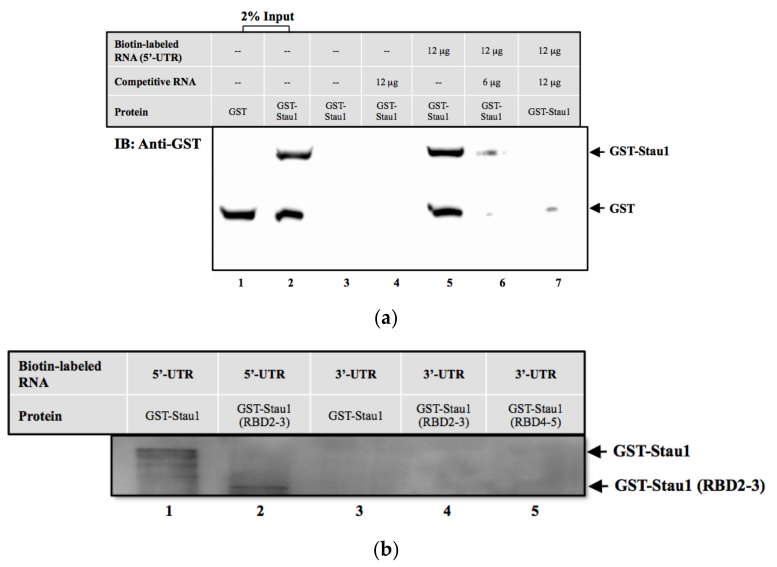
Figure 1. Stau1 binds to 5 (cid:48) untranslated region of EV-A71 RNA. ( A ) Stau1 binds to EV-A71 viral RNA in an in vitro RNA pulldown assay. The recombinant GST-tagged Stau1 protein was expressed and purified from Escherichia Coli . The biotin-labeled EV-A71 viral RNA was used for the RNA pulldown analysis. Lanes 1 and 2: Input of the recombinant GST or GST-Stau1 protein; Lane 3: GST-tagged Stau1 protein only; Lane 4: GST-tagged Stau1 protein interacted with non-biotin-labeled RNA (competitive RNA); Lane 5–7: GST-tagged Stau1 protein interacted with biotin-labeled RNA without or with competitive RNAs. ( B ) Stau1 binds to 5 (cid:48) -UTR but not 3 (cid:48) -UTR of EV-A71 RNA genome. GSI-tagged Stau1 protein was expressed for the in vitro RNA pulldown assay as described above. The GST-Stau1 (RBD2-3) is a truncated protein containing RNA-binding domain 2 and 3 as described in Section 3.2.